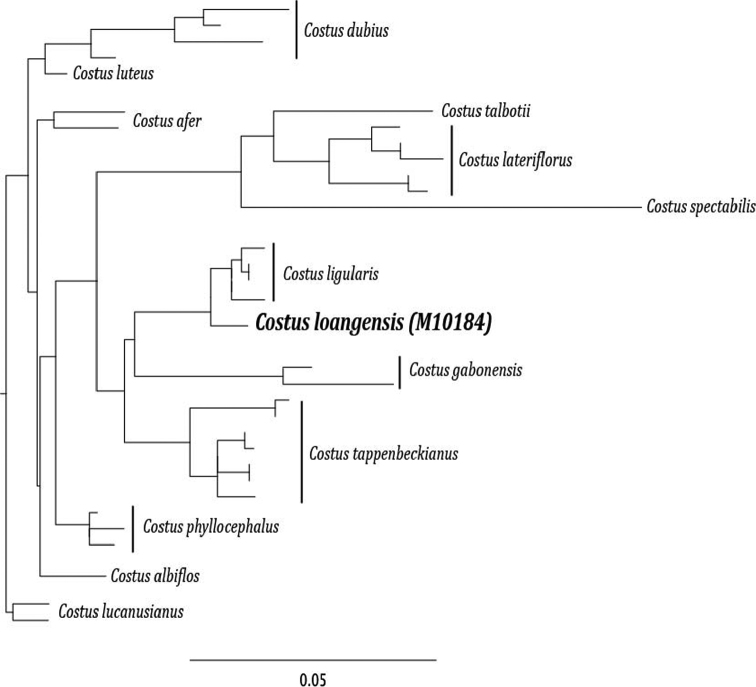
Phylogeny of African Costus species (Table 2) including newly described Costus loangensis. The phylogeny was constructed in PhyML (Guindon and Gascuel 2003) with aligned sequence data for two low copy nuclear markers [calmodulin (cam) intron (Johansen 2005) and rpb2 (Specht 2006a)] and nrDNA markers ITS and ETS. All nodes indicated have >50% bootstrap support.